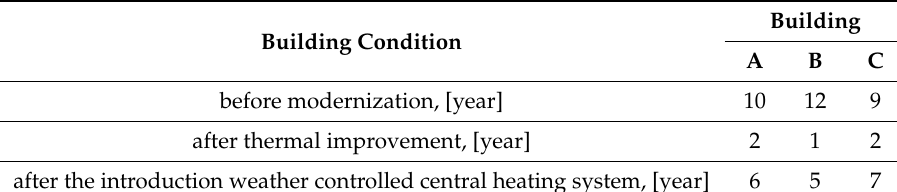
Table 3. Number of years of the measurement